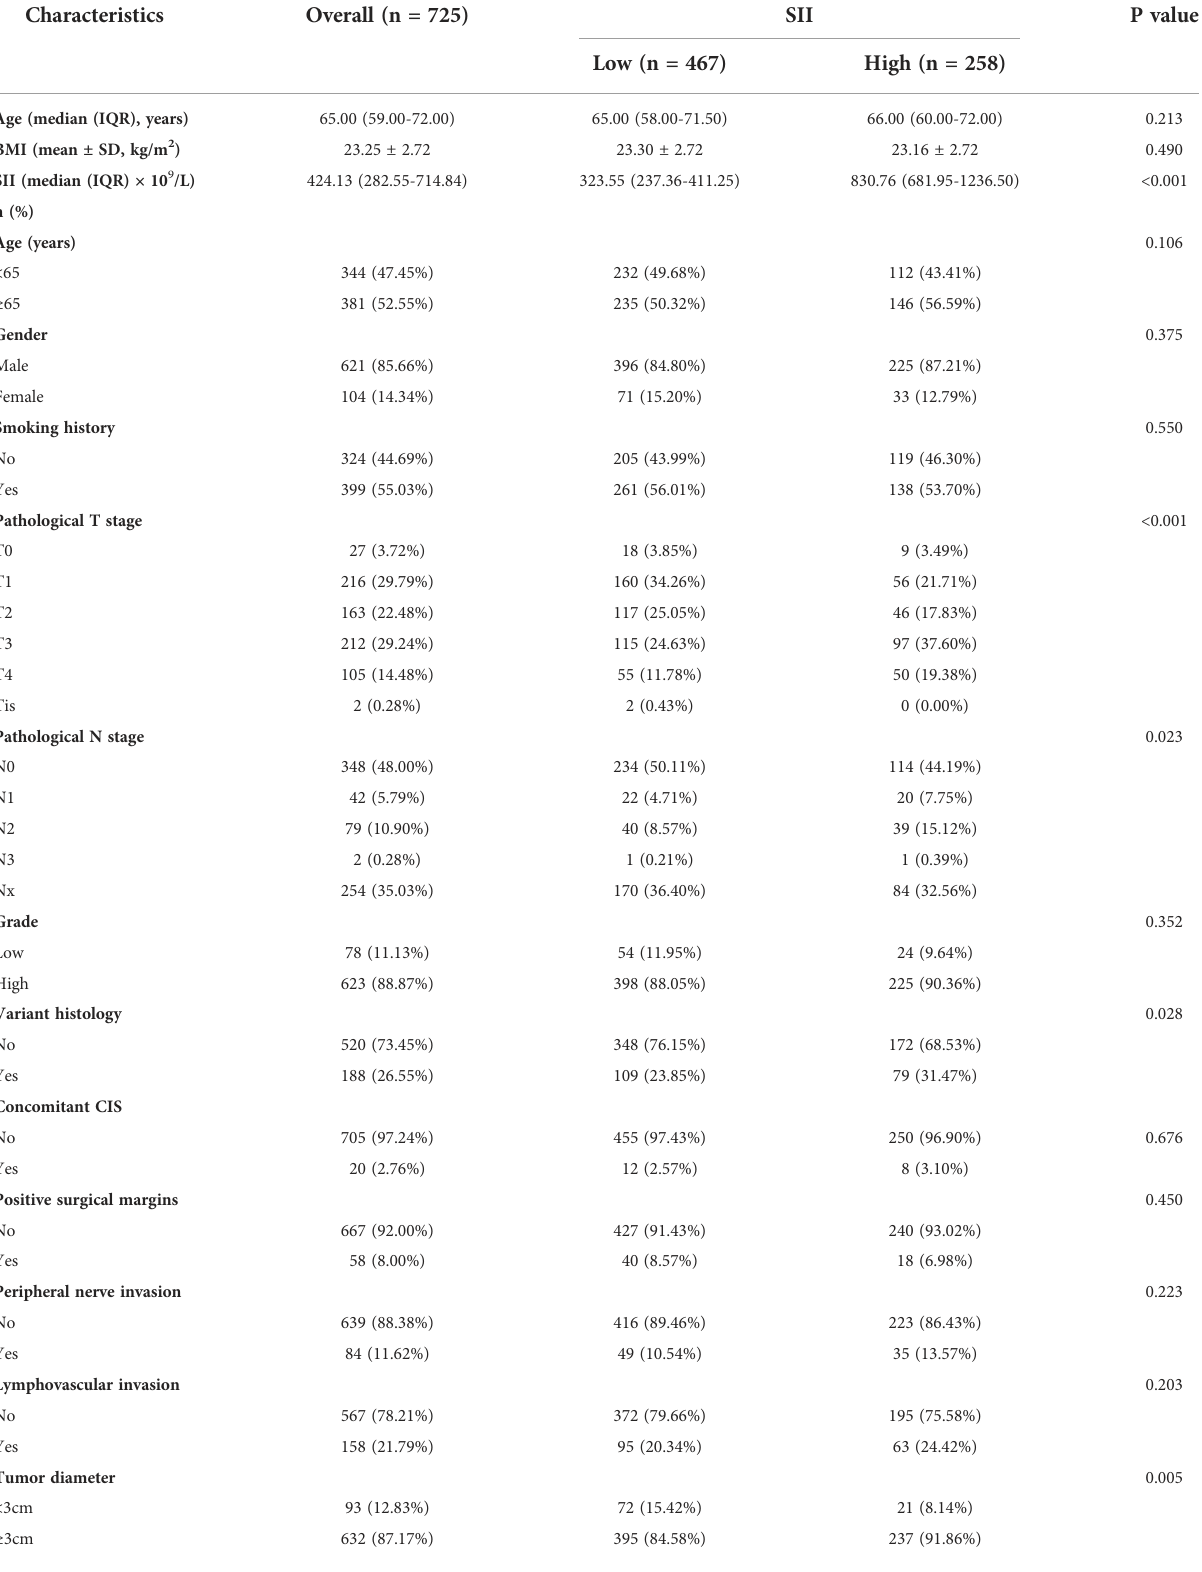
TABLE 1 Baseline characteristics of included